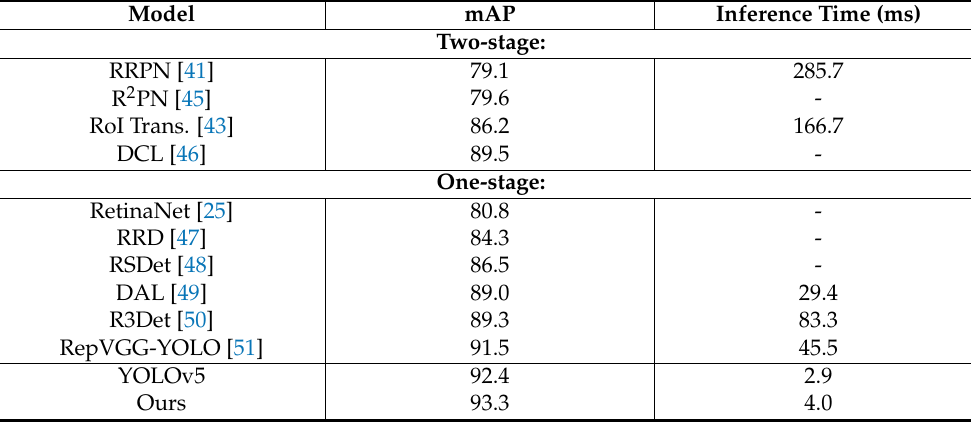
Table 7. The detection accuracy on the HRSC2016 dataset.